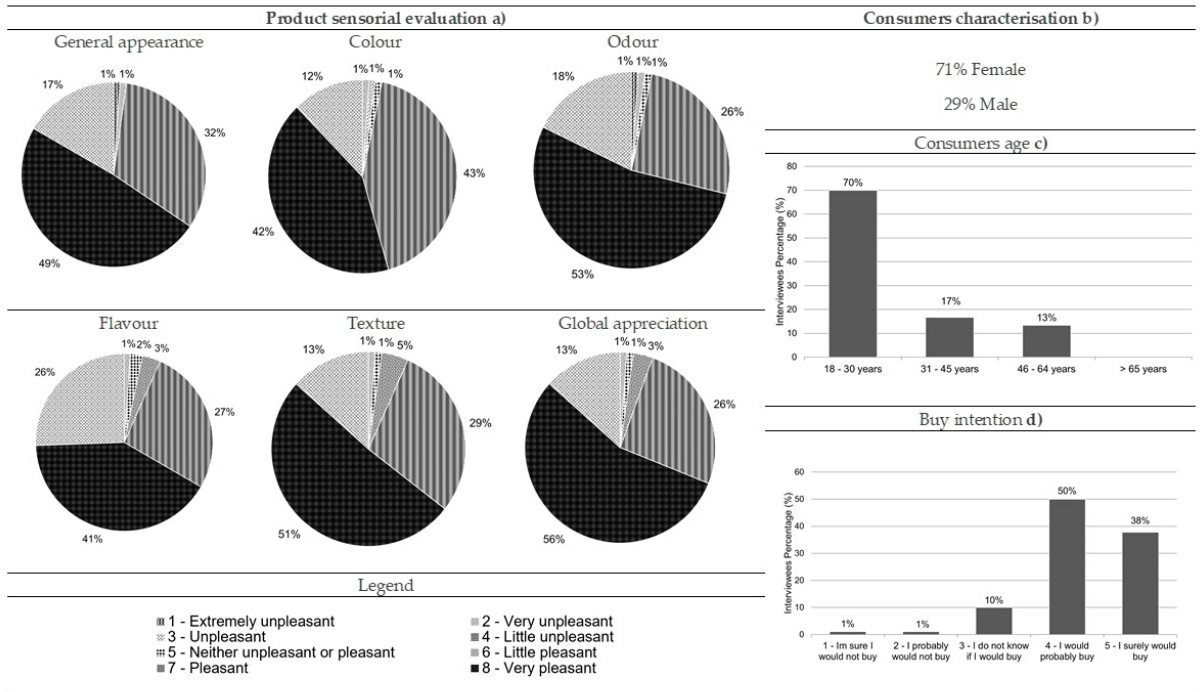
Figure 8. Results from the comber pastry consumer acceptance survey: ( a ) sensorial evaluation (product’s general appearance, colour, odour, flavour, texture and global appreciation), ( b ) consumers characterisation (gender percentage), ( c ) consumers age and ( d ) buy intention ( n = 90).